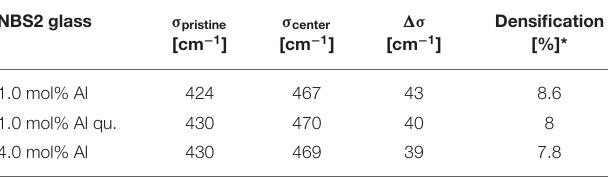
TABLE 5 | Raman study of the deformation process present during indentation. NBS2